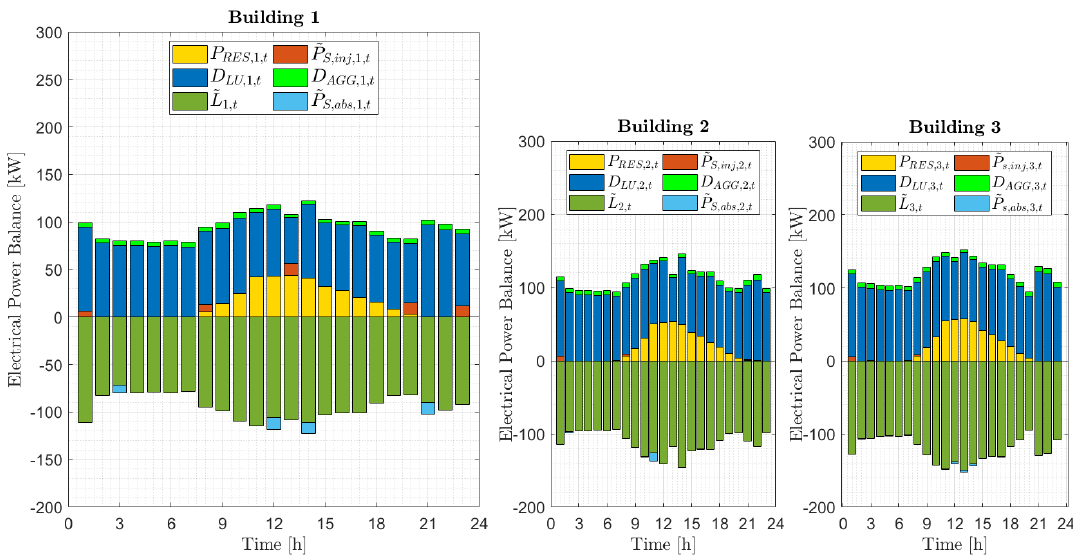
Figure 11. Electrical balance in the LUs (buildings).